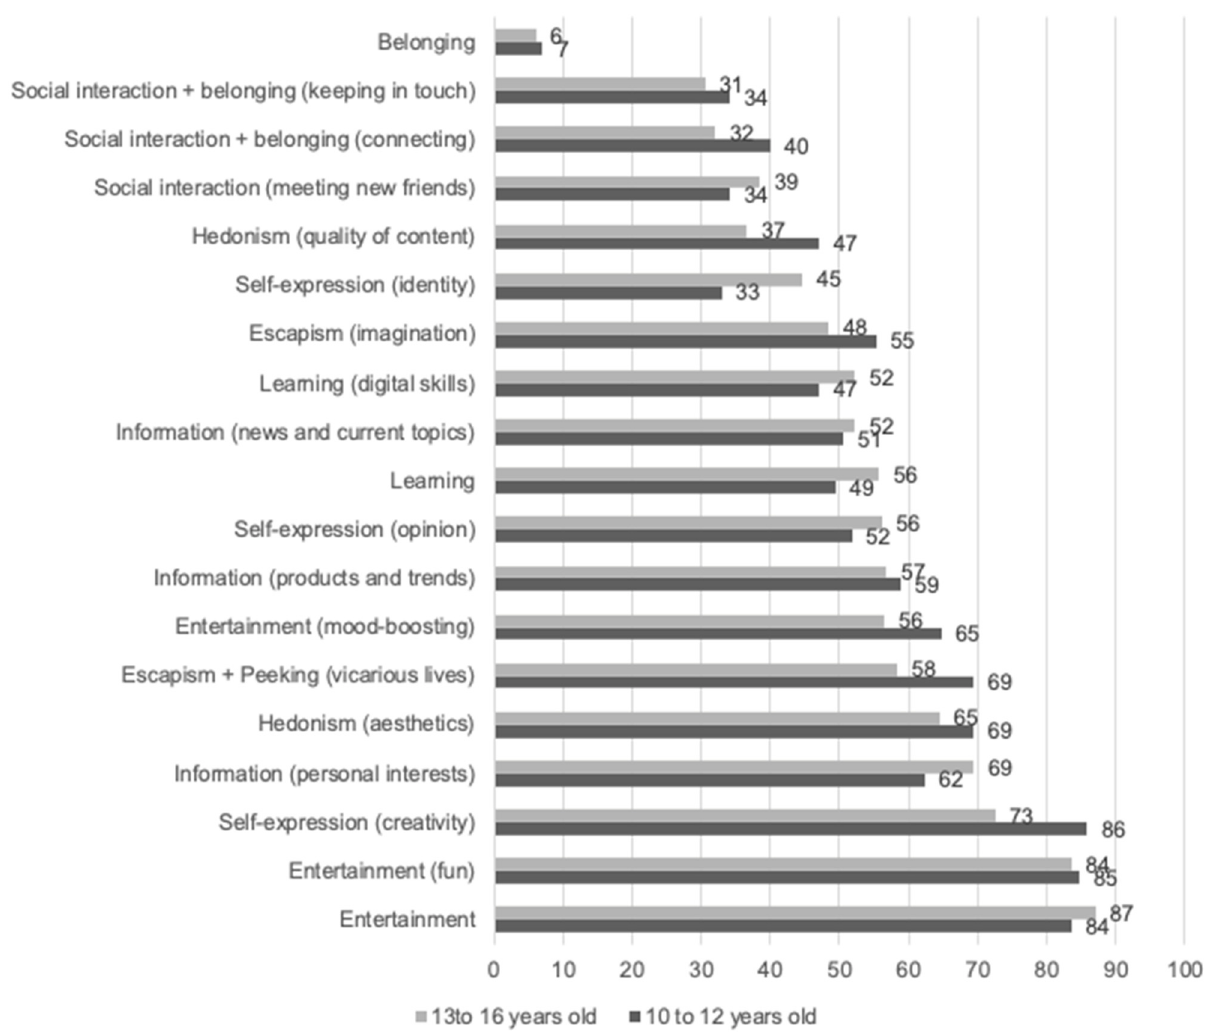
Figure 9. TikTok users who agree with expressions concerning motivations to use the platform and gratifications obtained (in percentage).